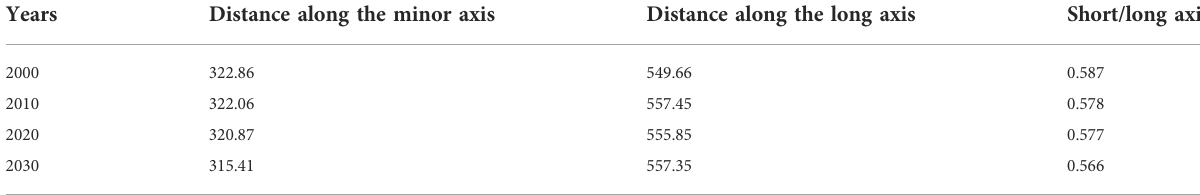
TABLE 3 The ellipse parameter values for the standard deviation of habitat